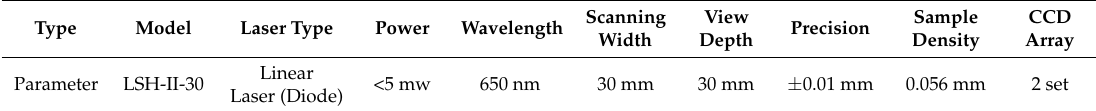
Table 1. The main technical parameters of the laser